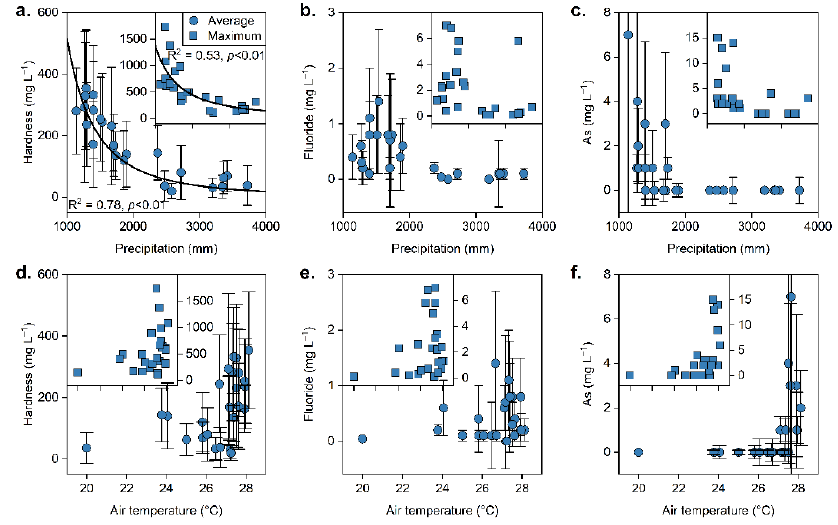
Figure 4. The relationships between hardness, fluoride, and As concentrations, and precipitation ( a –